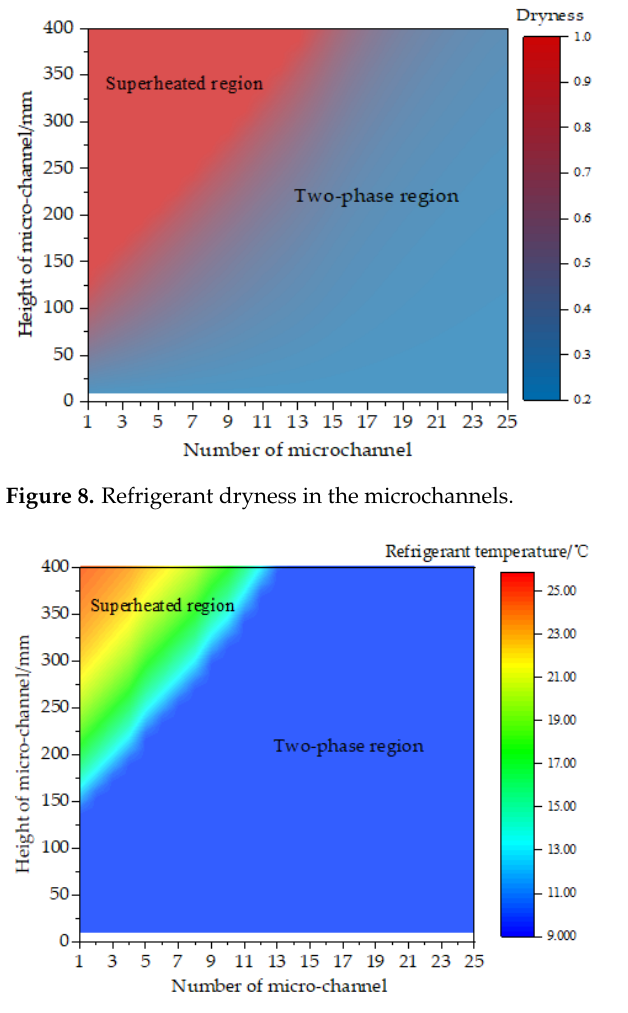
Figure 9. Refrigerant temperatures in the